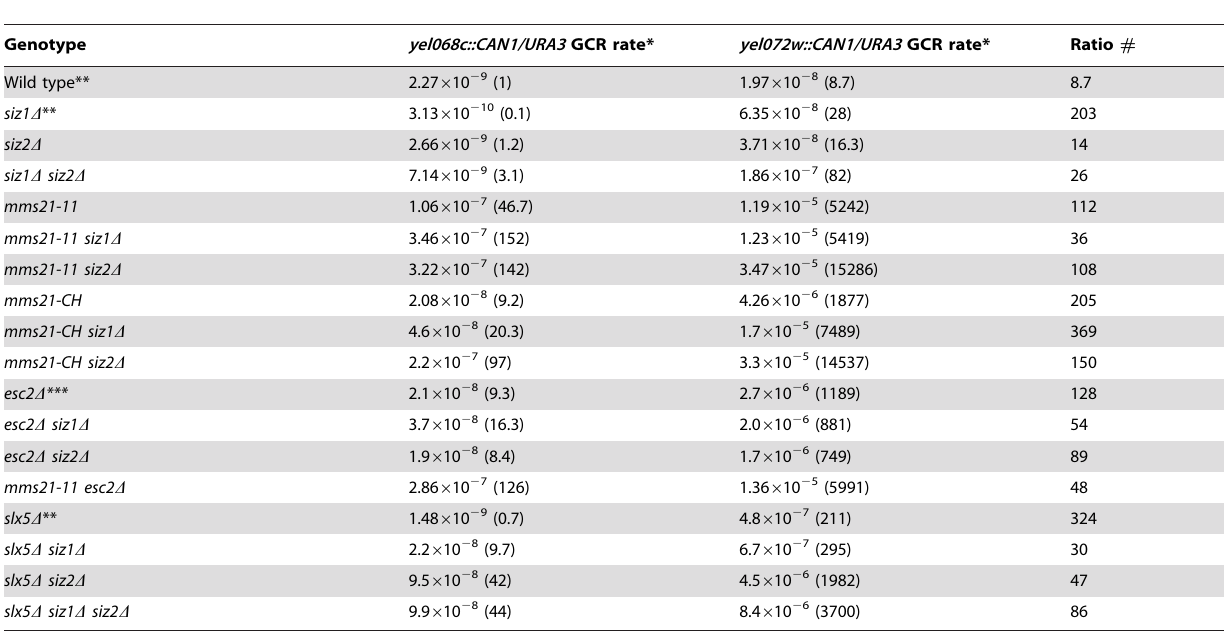
*Rate of accumulating Can 5-FOA progeny. Number in the parenthesis is the fold increase relative to wild-type yel068c:CAN1/URA3 strain. **Rates taken from [5,12]. ***Rates of esc2 D mutant are re-analyzed here. # The yel072w:CAN1/URA rate divided by the yel068c::CAN1/URA3 rate.